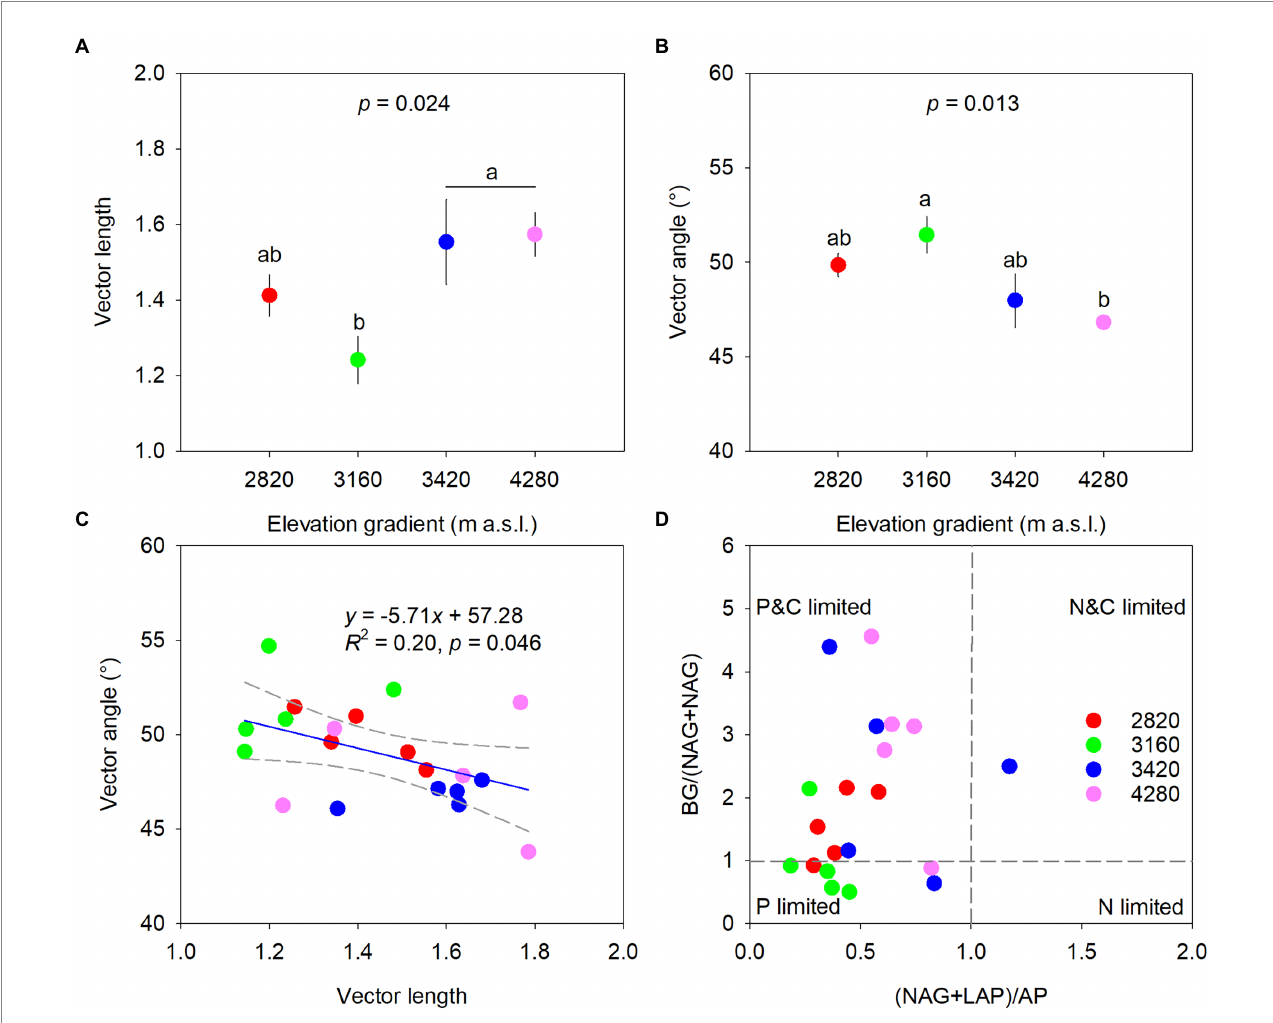
FIGURE 3 Variations of vector length (A) and vector angle (B) , and the relationships between vector length and vector angle (C) and between BG:(NAG+LAP) and (NAG+LAP):AP (D) along the elevational gradient to identify potential resource limitations of soil microbes. Data in the upper two panels are mean ± standard error, and different letters represent significances among elevations at a level of p < 0.05. The blue line indicates the linear regression and regression bands of two gray dashed lines represent 95% confidence intervals in the panel (C)